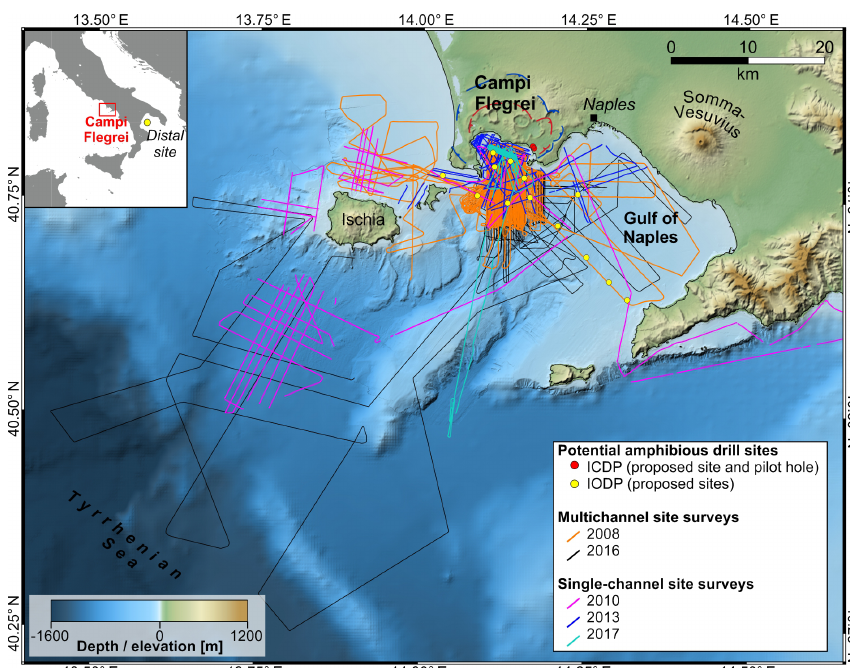
Figure 3. Offshore site-survey seismic data package (high-resolution multichannel and single-channel reflection seismic profiles) supporting the IODP component of the Campi Flegrei Amphibious Drilling Proposal. Locations of the proposed IODP drill sites and the ICDP site and pilot hole drilled in 2012 are also